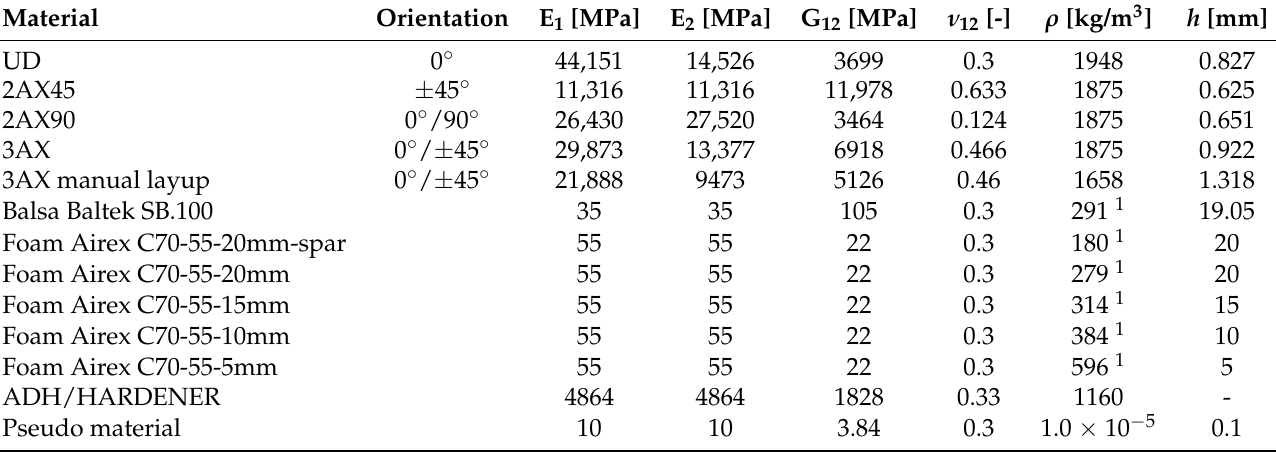
Table 4. Material parameters based on [12]. 1—Values after matrix